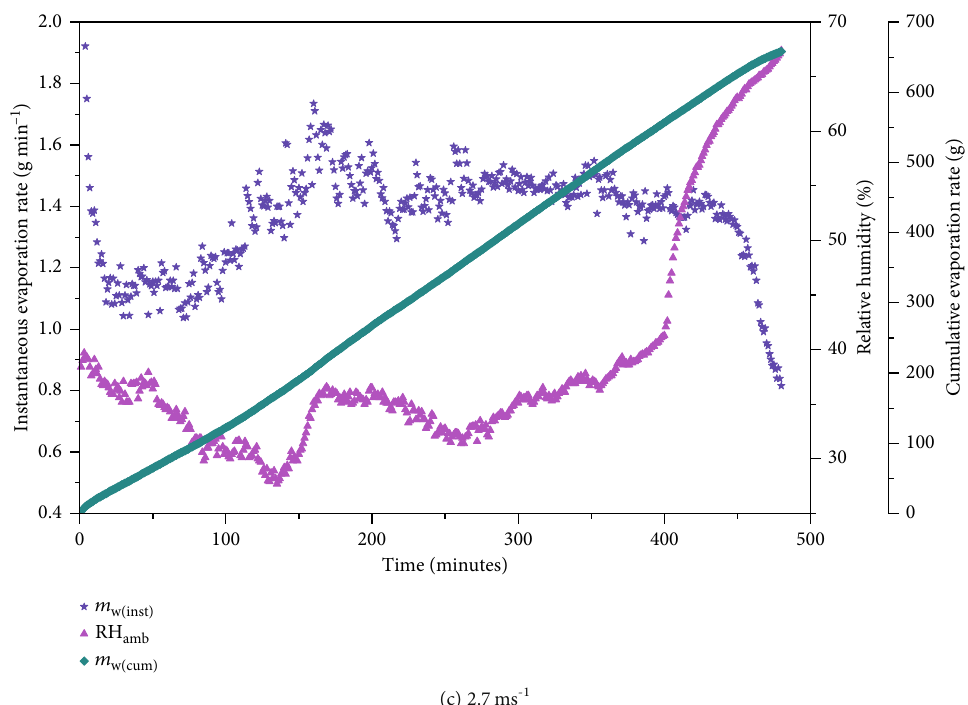
Figure 17: Ambient RH and instantaneous and cumulative evaporation rates of the air cooler at three di ff erent velocities under low RH condition.